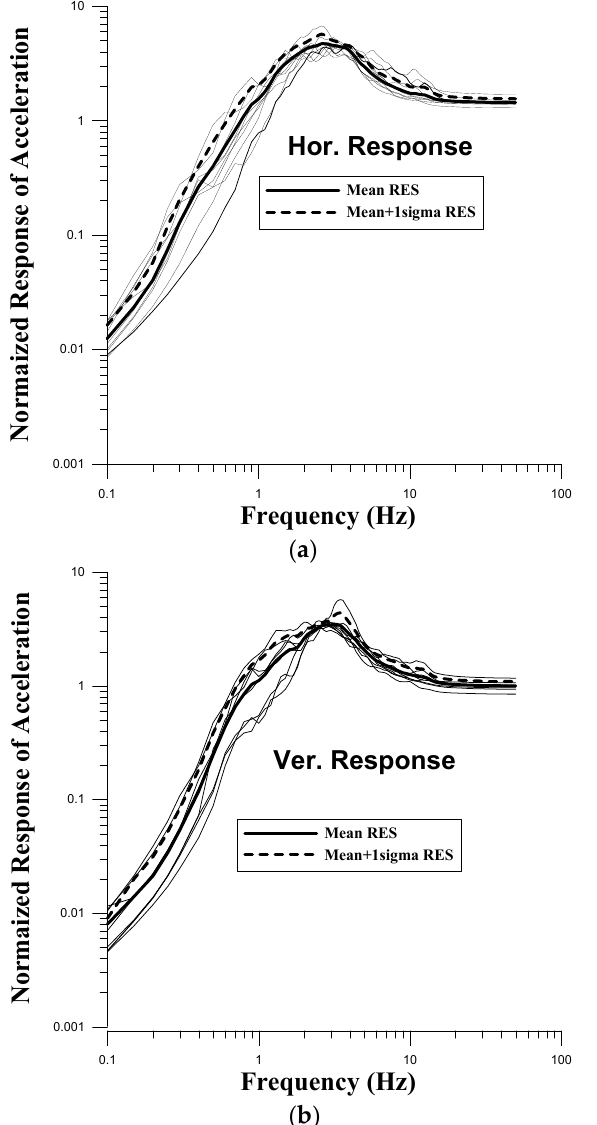
Figure 8. Mean and mean +1 σ , ( a ) horizontal and ( b ) vertical response spectra of all the events and 8 stations.